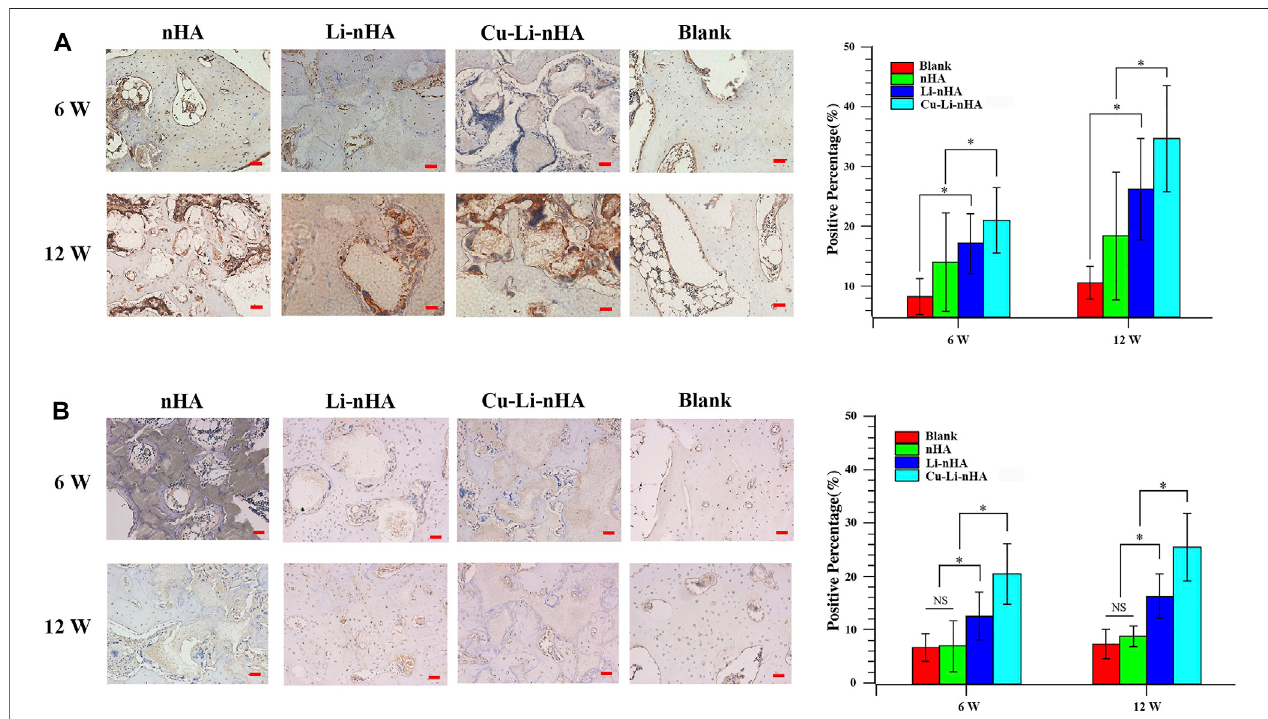
FIGURE 8 | Immunohistochemistry and positive ratio analysis of OCN (A) , Runx2 (B) . Blank Group: without ONFH modeling and scaffold-implantation operation. Scale bar in the bottom right-hand corner of each image (red): 100 μ m. Statistical analysis was conducted using a one-way analysis of variance with post-hoc Bonferroni ’ s multiple comparisons test. NS: p > 0.05, * p <